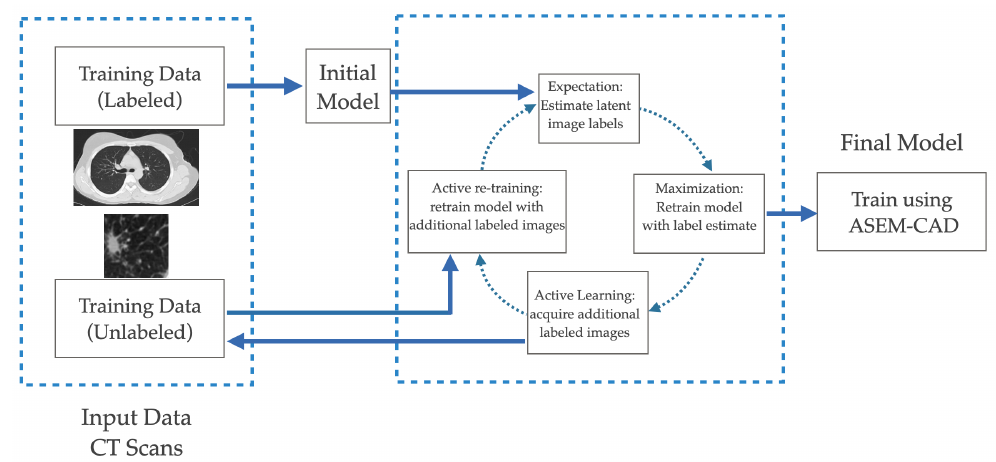
Figure 1. An active, semisupervised expectation maximization (ASEM) framework for CAD